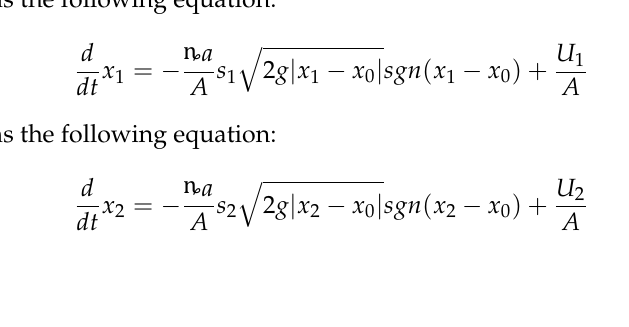
Figure 2. Proposed Three-Pond run-of-river hydropower plant (top view).